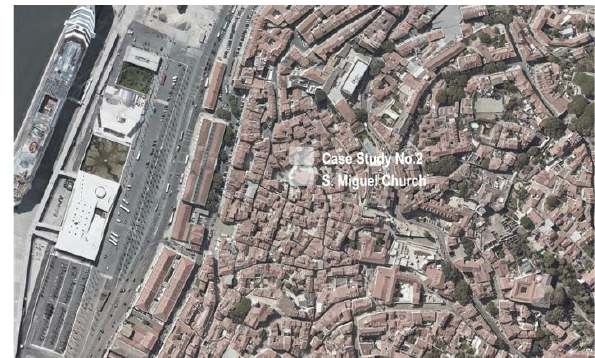
Figure 3. Location of case study No.2, Beco de São Miguel no.17, Lisbon.